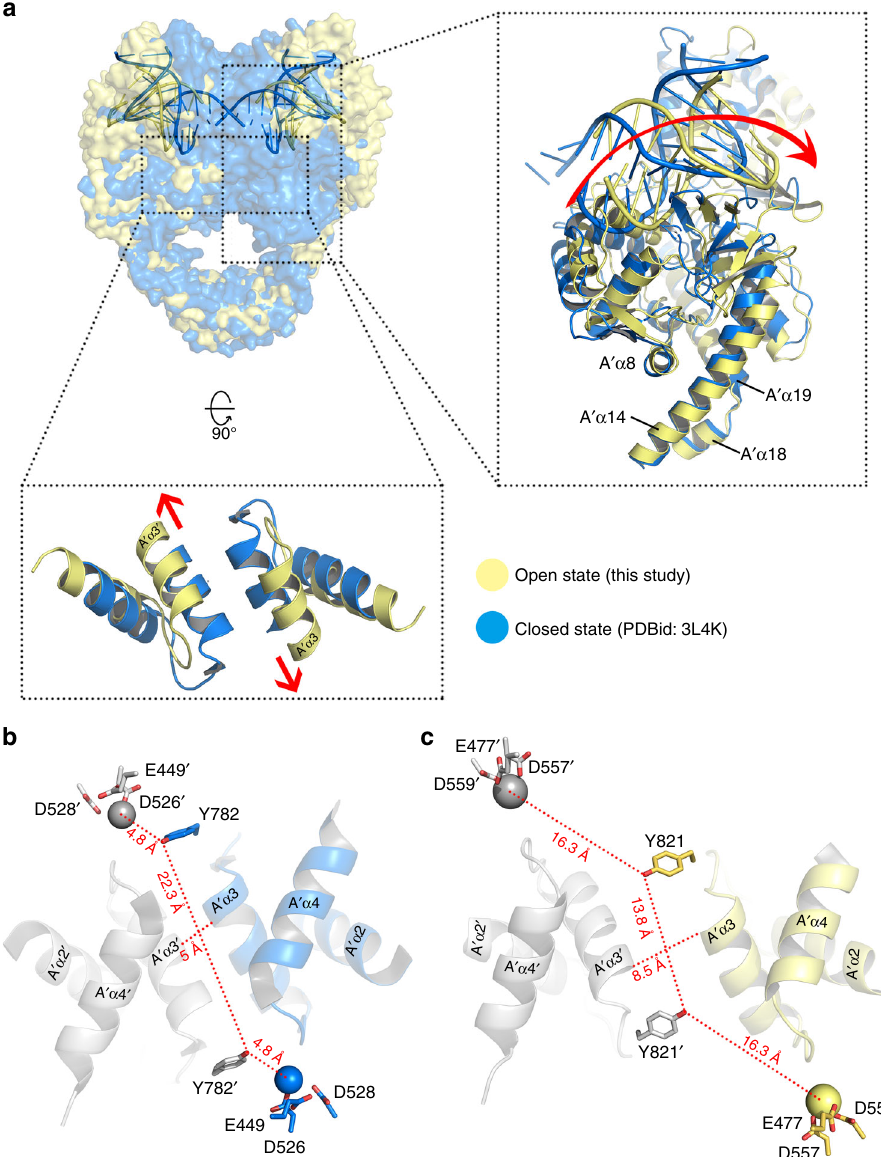
Fig. 3 Quaternary and tertiary changes associated with DNA-gate opening. a Superposition of the eukaryotic C-terminal dimerization domain of the closed 12 (PDBid: 3L4K) and open (PDBid: 5ZEN, this study) conformations reveals that opening of the DNA-gate is achieved by the two subunits sliding against each other (enclosed view, bottom) plus an intra-subunit fl exing (enclosed view, right). The closed and open DNA-gate conformations are colored blue and light yellow, respectively. The directions of quaternary sliding about the molecular dyad of Top2 and the tertiary fl exing about the hinge located close to the junction of A ′ α 14, A ′ α 18, and A ′ α 19 are indicated by arrows. b , c Top view (down the molecular dyad of the Top2 homodimer) of selected structural elements lining the bottom side of the DNA-conducting path and key catalytic groups in the closed ( b ) and open ( c ) conformations. For each conformation, the catalytic tyrosines, the divalent cations (shown as spheres), and the distance between two catalytic tyrosines are shown to illustrate structural changed in the DNA-gate during the closed-to-open transition. Residues from different monomers are colored differently, with labels belonging to the second monomer fl agged by a